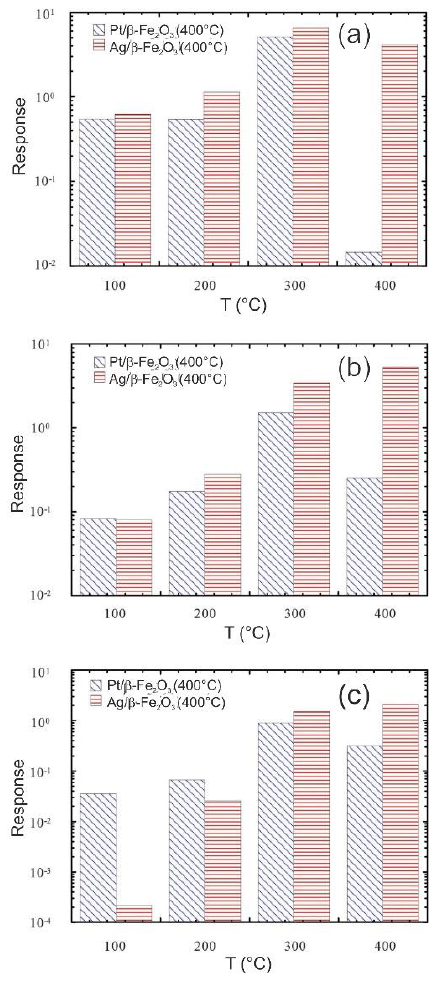
Figure 5. Responses of Ag / β -Fe 2 O 3 and Pt / β -Fe 2 O 3 samples at di ff erent working temperatures to: ( a ) H 2 , 5000 ppm, ( b ) ethanol (CH 3 CH 2 OH), 500 ppm, ( c ) acetone CH 3 COCH 3 , 100 ppm. Reproduced with permission from [69].